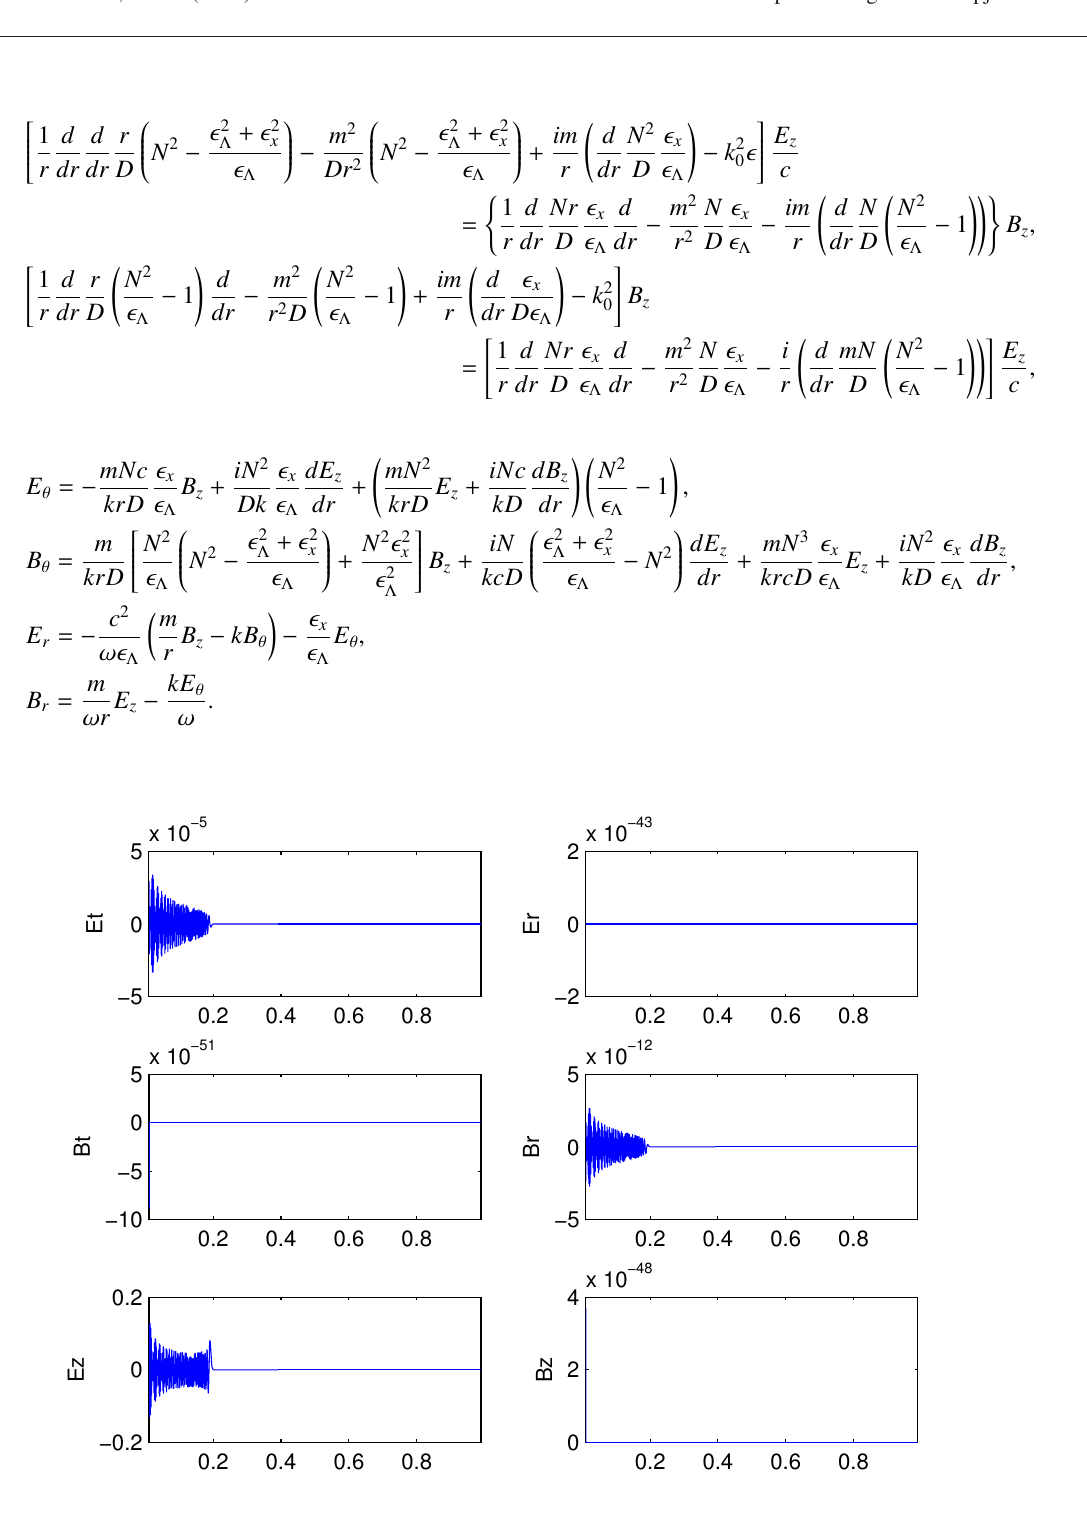
of the spectrum with multi-peaks have been observed, and the frequency interval is around 3